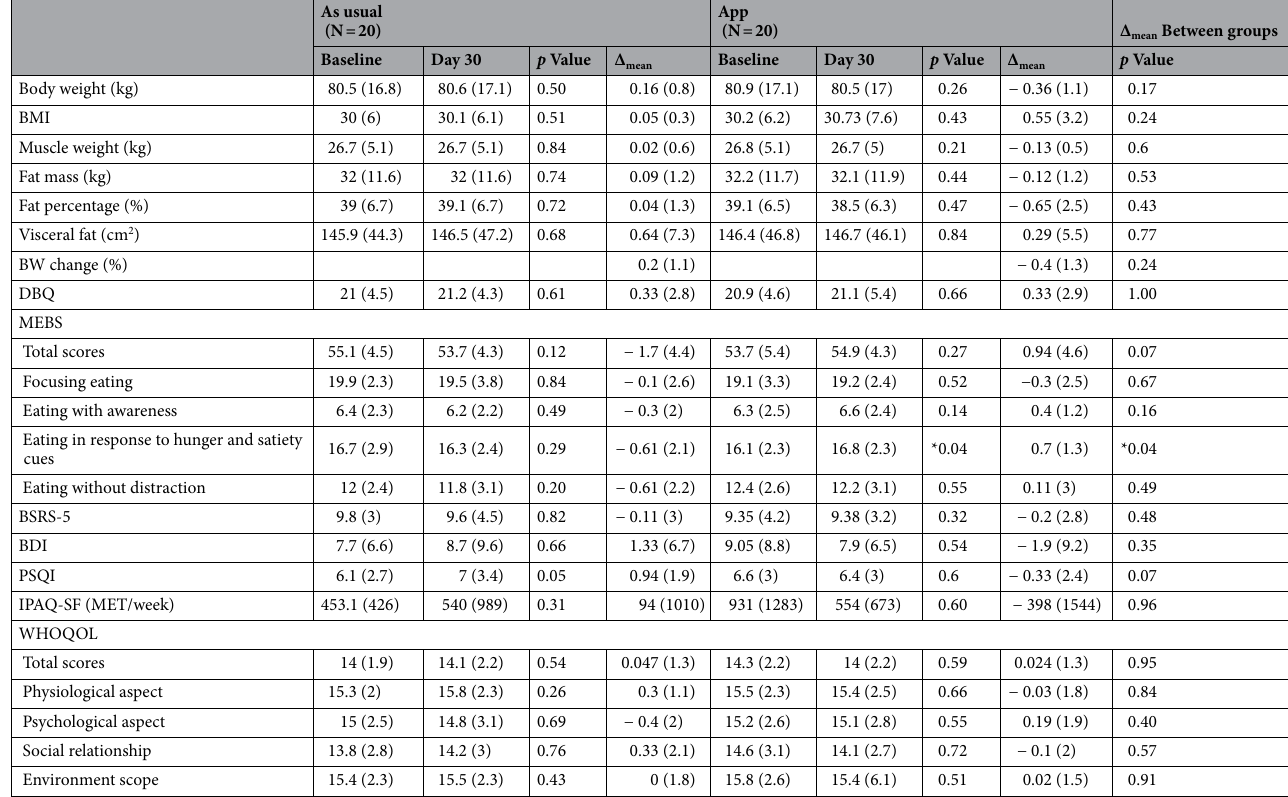
Table 3. Comparisons of outcomes in the integrated groups as App intervention and Life as usual. DBQ Dietary Behavior Questionnaire; MEBS Mindful Eating Behavior Scale; BSRS-5 five-item Brief Symptoms quality of life. * p < 0.05; Data were mean